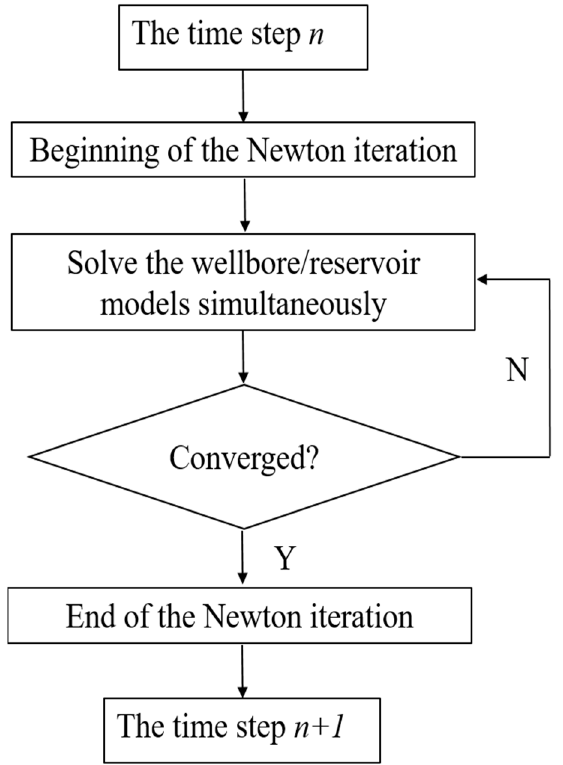
Figure 6. Schematic of the fully implicit coupling scheme.